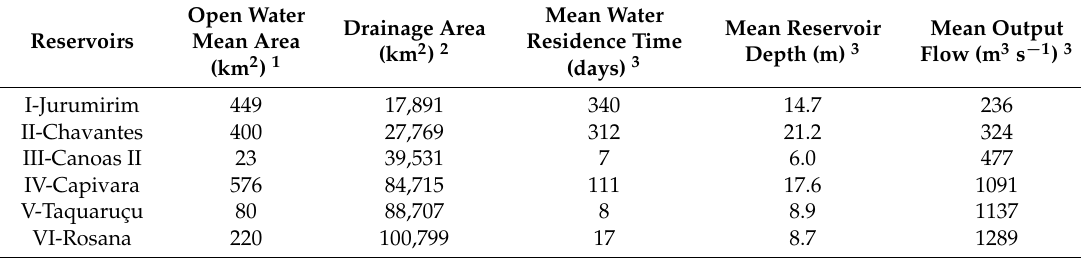
Figure 1. Map of the Paranapanema River catchment showing the locations of the hydropower dams (white bars) and turbidity sampling stations (black triangles). The six reservoirs studied in this article are numbered from upstream to downstream (I to VI). Table 1. Characteristics of the six studied hydropower dams distributed along the Paranapanema River.